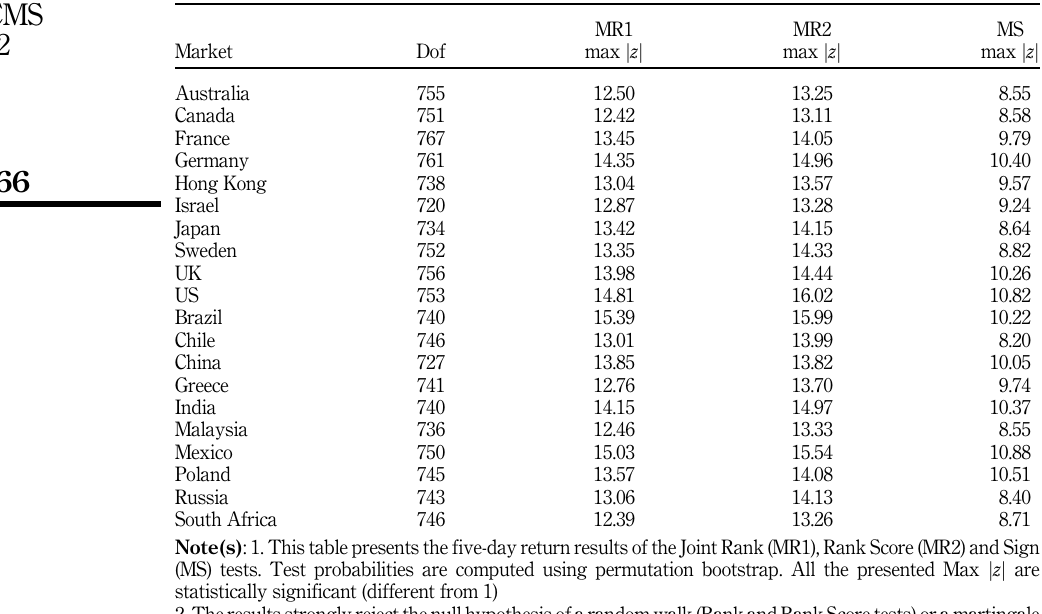
Table A2. Results of Joint Rank, Rank Score and Sign tests based on five-day